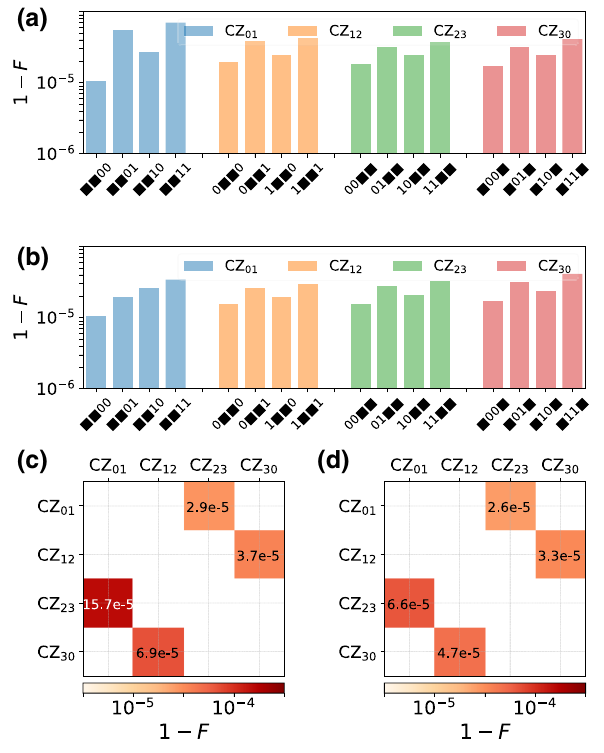
FIG. 10. (a),(b) CZ gate error with the other two nonpar- ticipating qubits in four different state configurations (i.e., 00, 01, 10, 11) for the four-qubit square system. (c),(d) Error matrix of the parallel implemented CZ gate operations in the four-qubit square system. In (a),(c), the qubit anharmonicity is η Q / 2 π = − 310 MHz. In (b),(d), the qubit anharmonicity is / 2 π = − 320 MHz. The other system parameters are the same η Q as those in Fig. 5(c).